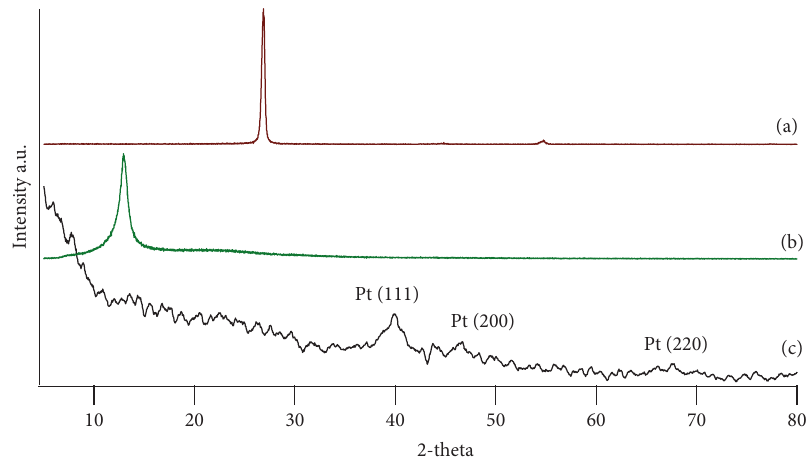
Figure 1: XRD patents of ExG (a), GO (b), and PtAl/rGO catalyst (c).